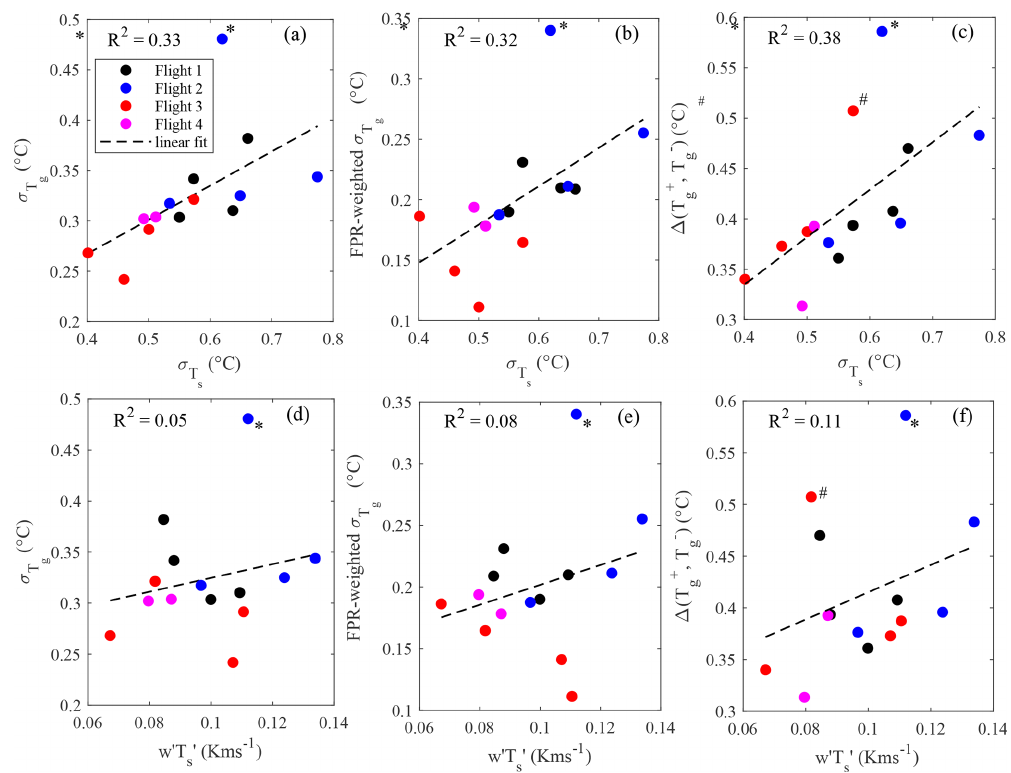
Figure 13. Drone data ( a – standard deviation of the ground temperature; b – EC footprint-weighted standard deviation of the ground temperature, footprint based on Kormann and Meixner, 2001; c – difference between the mean temperature excursions in cold and warm eddy traces) against the standard deviation of sonic temperature. In (d) – (f) , the same quantities as in (a) – (c) are plotted against the kinematic sensible heat flux. * and # indicate the outlying 5min periods in the beginnings of flights 2 and 3 when particularly strong coherent structures